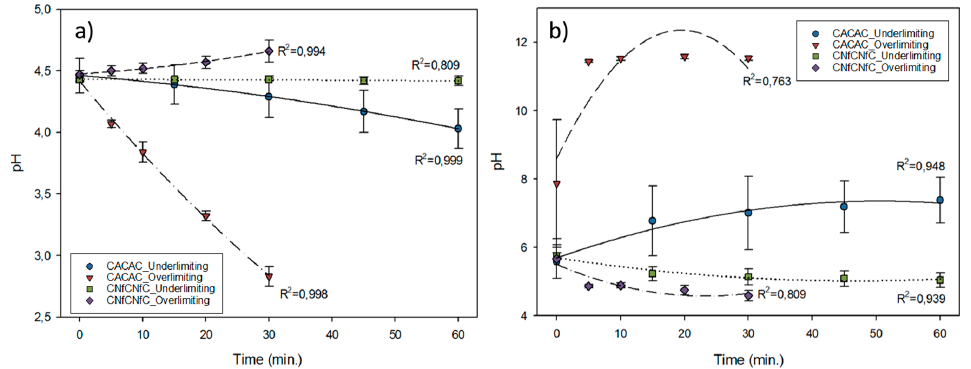
Figure 4. pH evolution in ( a ) whey and ( b ) NaCl solution during electrodialysis (ED) according to the configurations (CACAC and CNfCNf) and the current conditions (underlimiting and overlimiting) used.